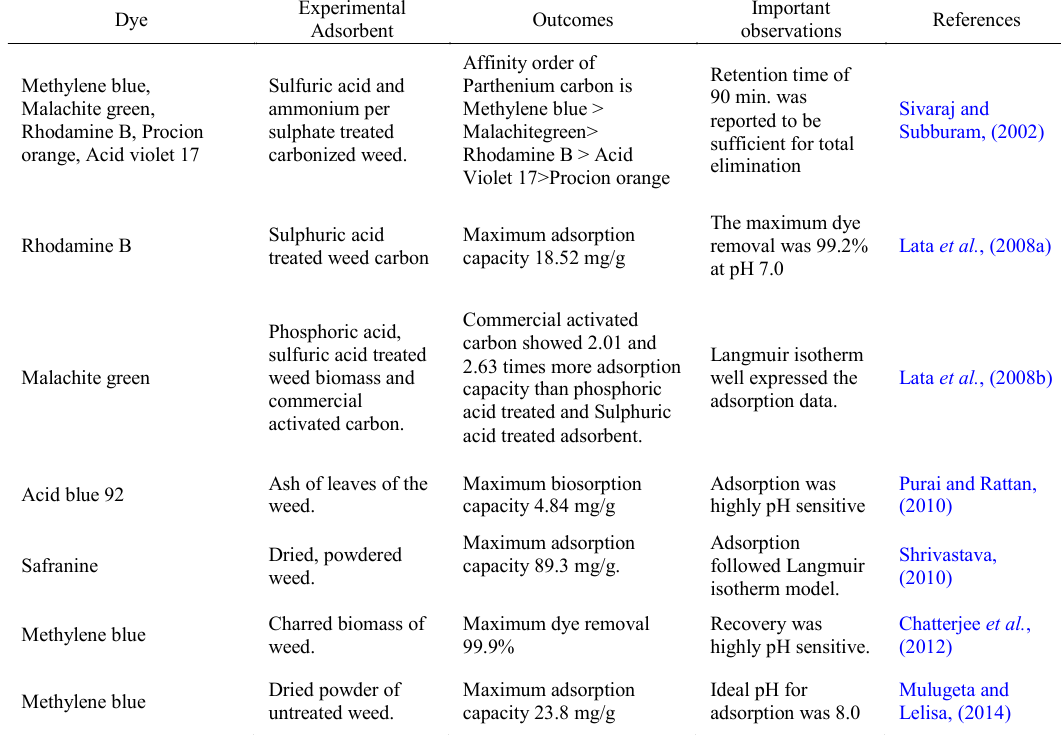
Table 2: Parthenium hysterophorus for removal of